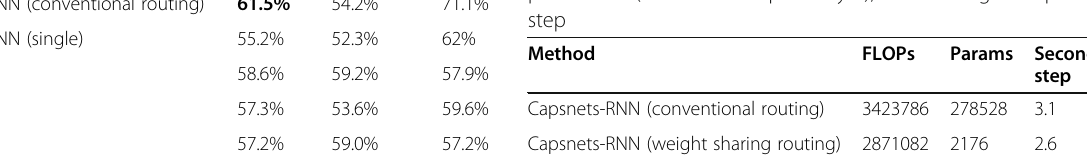
Table 6 Comparison of the FLOPs, number of trainable parameters (the second capsule layer), and training time